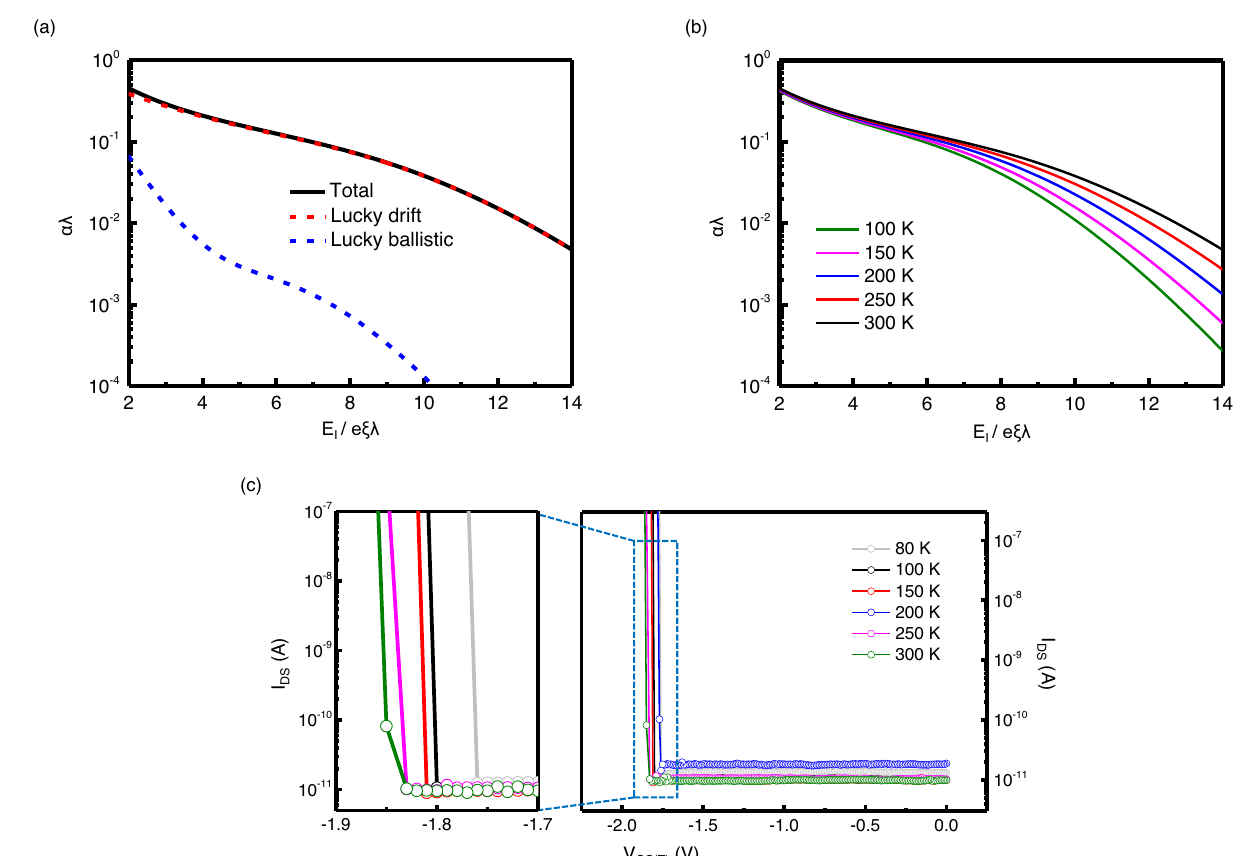
Fig. 4 | Theoretical clari fi cation of impact ionization. a Calculated total ioniza- tioncoef fi cientsofbulkWSe 2 atroomtemperature(solidblackcurve)asafunction of E I / e ξλ , where E I is the ionization energy, ξ is the strength of the applied electric fi eld,and λ isthemeanfreepath.Thecontributionsofthelucky-ballisticmode(red curves)andlucky-driftmode(bluecurves)arealsoshown. b Ionizationcoef fi cients